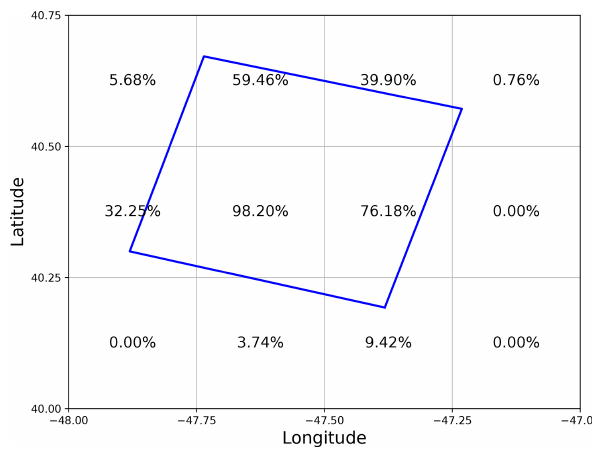
Figure 1. A GOME-2A ground pixel (blue) overlaid on a 0.25 ◦ × 0.25 ◦ latitude–longitude grid (grey). The percentage of overlap (weighting) for each grid box is